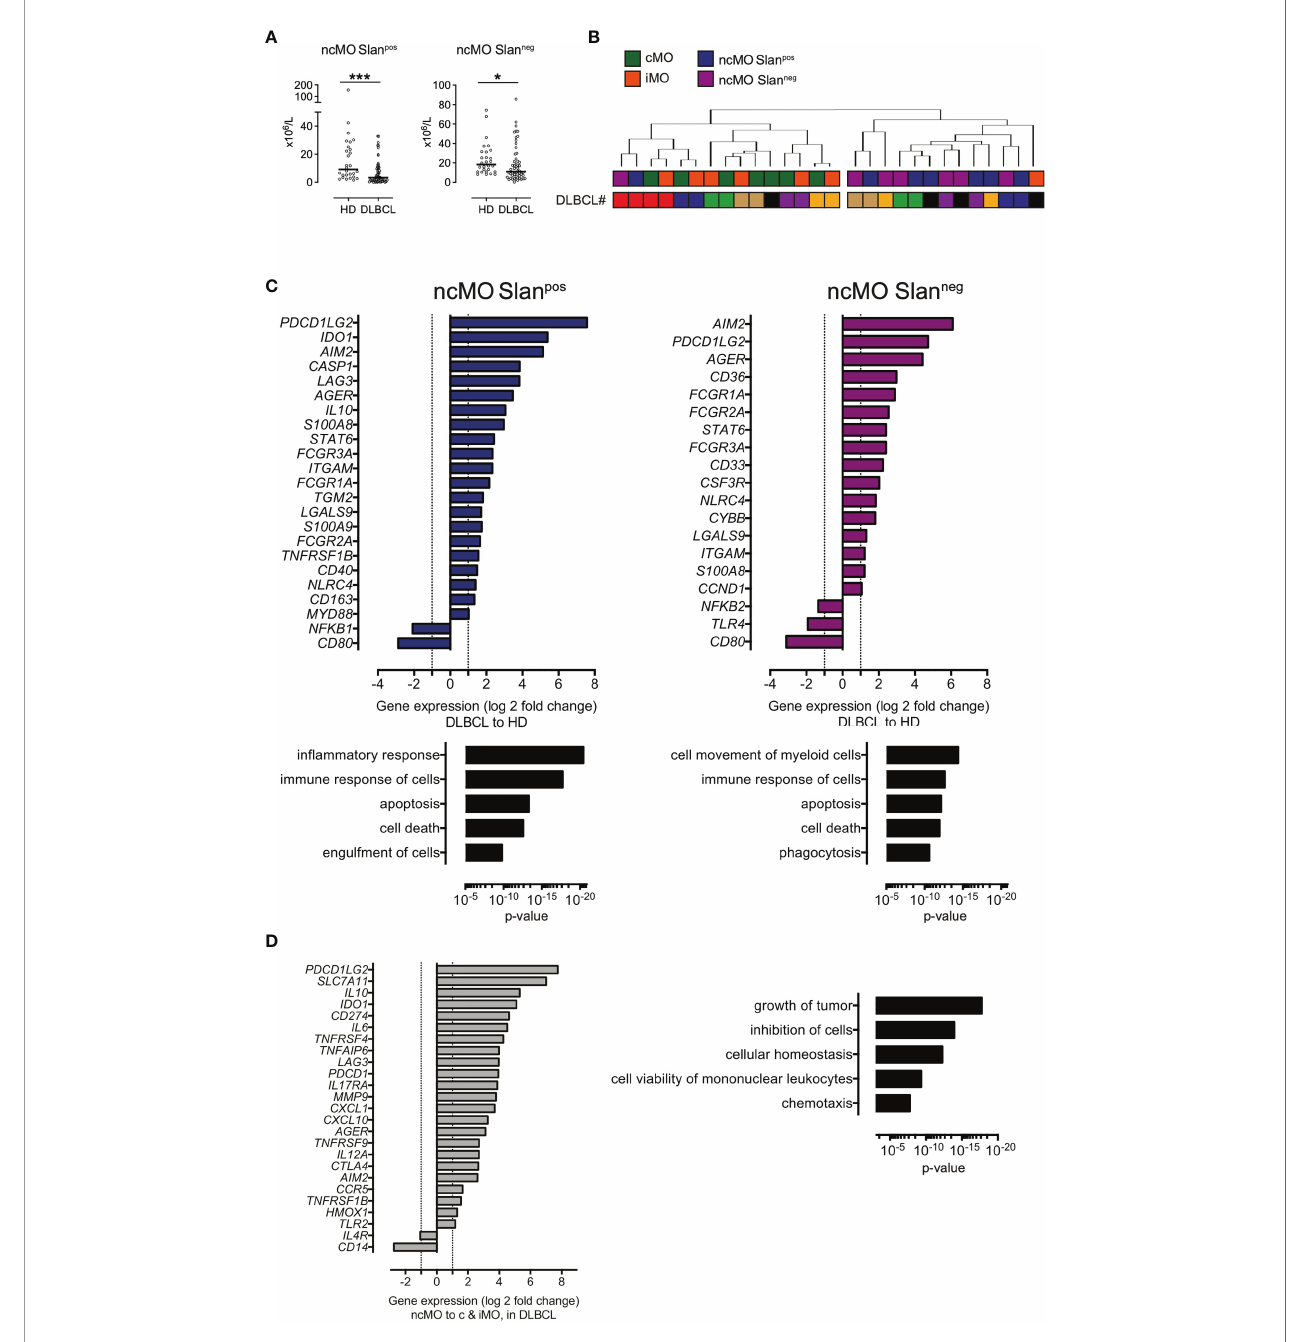
FIGURE 3 | ncMO are decreased in peripheral blood but exhibit an in fl ammatory- and tolerogenic- phenotype. (A) Nonclassical Slan pos or Slan neg (ncMOSlan pos and ncMoSlan neg ) monocytes from HDs (n = 28) and DLBCLs (n = 56). Mann-Whitney test were performed. *P <.05, ***P <.001. (B) Unsupervised hierarchical clustering of classical- (cMO), intermediate- (iMO), nonclassical Slan pos - or Slan neg - (ncMOSlan pos and ncMoSlan neg ) monocytes from DLBCL (n = 7) samples. DLBCL identity (#). List of genes analyzed on monocyte subsets after cell sorting is on Table S3 . Pearson ’ s correlation and complete linkage was employed. (C) Transcripts differentially expressed (P <.05; ∣ log2FC ∣ > 1) between DLBCLs (n=7) and HDs (n=4), for ncMO Slan pos and ncMO Slan neg . Predicted top 5 biological processes increased for ncMO Slan pos and ncMO Slan neg from DLBCL when compared to HD samples (Ingenuity Pathway Analysis, z-score > 2.5, ranked by p-value). (D) Transcripts (P <.05; ∣ log2FC ∣ > 1) enriched in ncMO compared to cMO and iMO for DLBCL. Predicted top 5 biological processes increased for ncMO compared to cMO and iMO, from DLBCL (Ingenuity Pathway Analysis, z-score > 2.5, ranked by